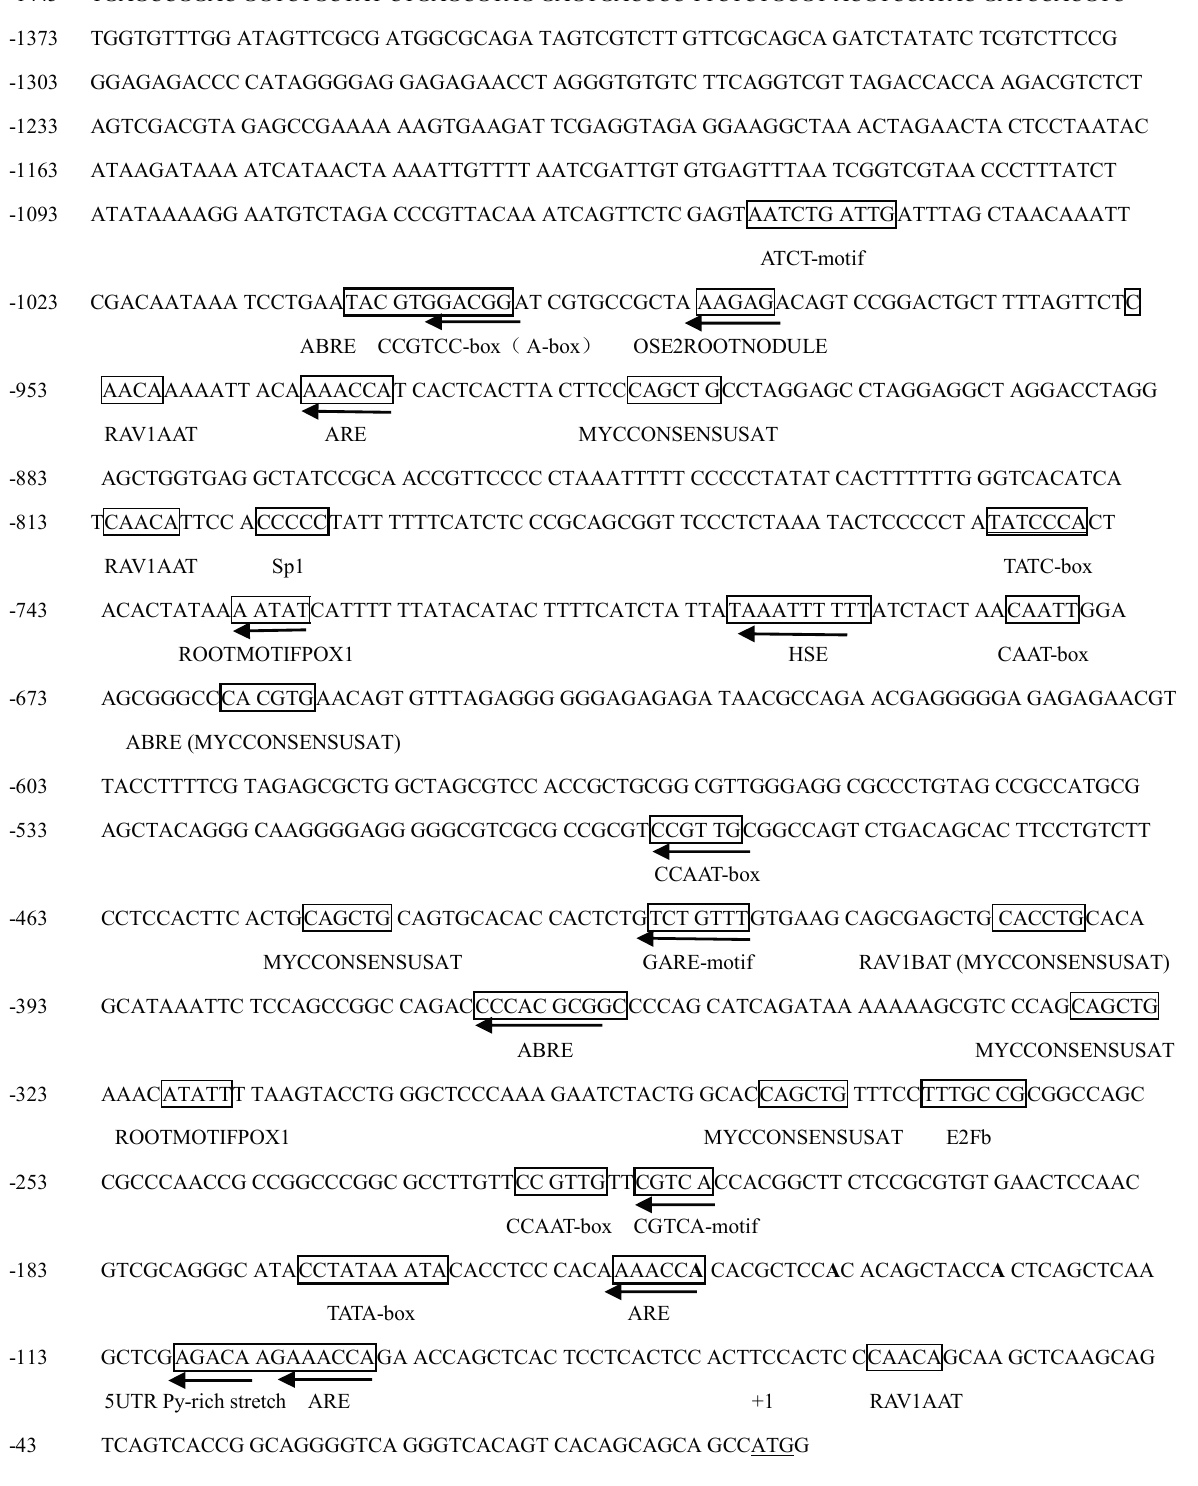
Figure 1. Nucleotide sequence and putative cis -acting elements of the ZmCBF3 promoter (P ZmCBF3 ). The cis -acting elements are boxed, and arrows indicate their direction. The translation initiation codon is